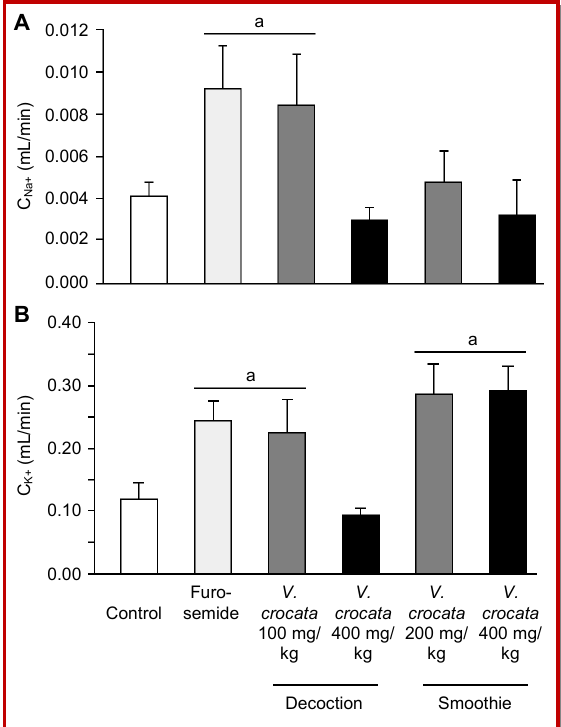
Figure 2: A) Sodium clearance (C Na+ ), B) Potassium clearance (C K+ ). Data are mean ± SEM., n = 6, a p<0.05 compared to con- trol